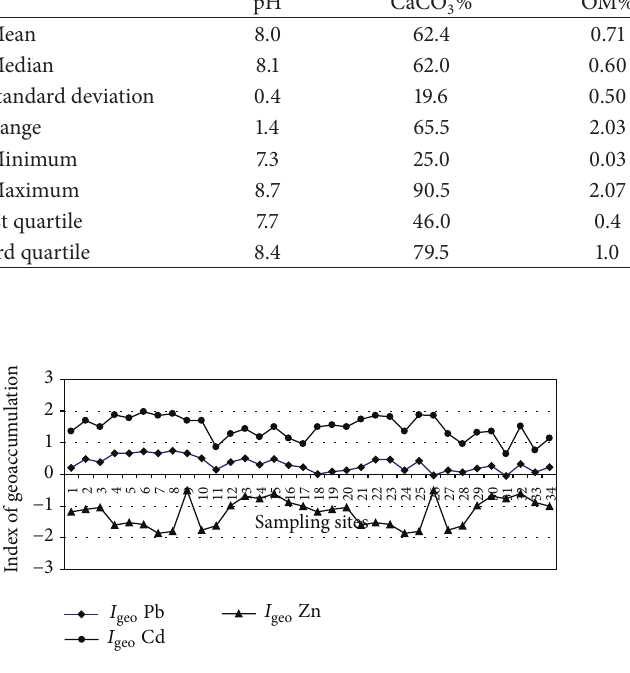
Figure 2: Geoaccumulation index values of Pb, Cd, and Zn in the studied soil samples. Figure 3: CF values of Pb, Cd, and Zn and PLI in the studied soil